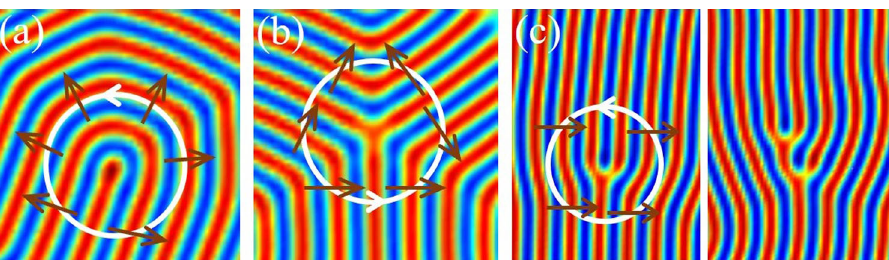
Fig. 1 Topological defects in active smectics. Typical topological defects found in simulations of active smectic pattern as determined by the density fi eld pro fi le, including ( a ) + 1/2 and ( b ) − 1/2 disclinations, and ( c ) a single and a doublet of edge dislocations. Some local normal directions of smectic layers are indicated by arrows, and an integral of their orientational angle θ s over a counterclockwise closed-path loop around the defect core (white-circled) determines its topological charge via ∮ d θ s /2 π = ± 1/2, 0 for disclinations and dislocations respectively. (Note that angles θ s with a π difference are equivalent to conditions and a setup of boundary via V b ( r ) = V b 0 ϕ ( r ) with an